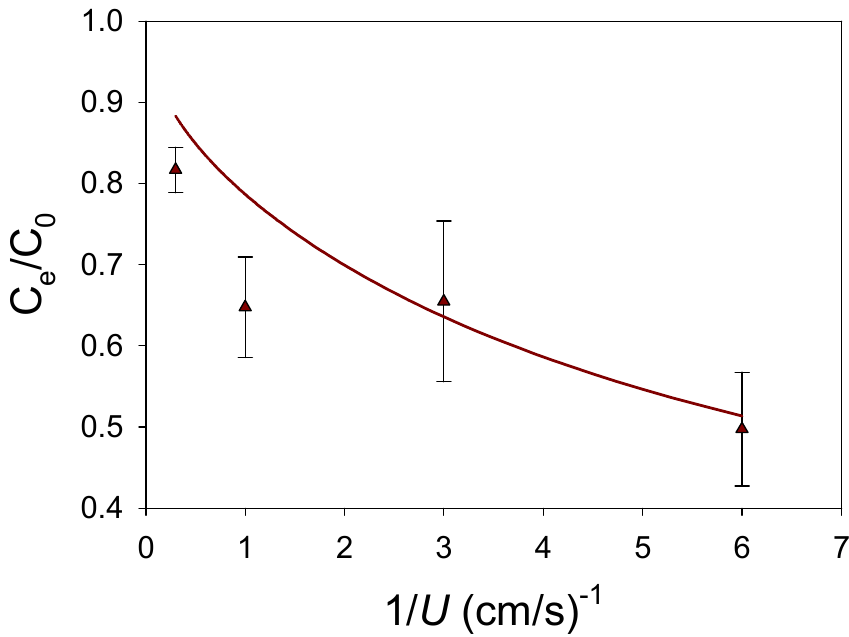
Fig. 5 (b). Comparison of experimental (triangles) and analytical (solid line) results for insulin (C 0 = 500 nM) diffusivity in phosphate buffer (pH7.4, room